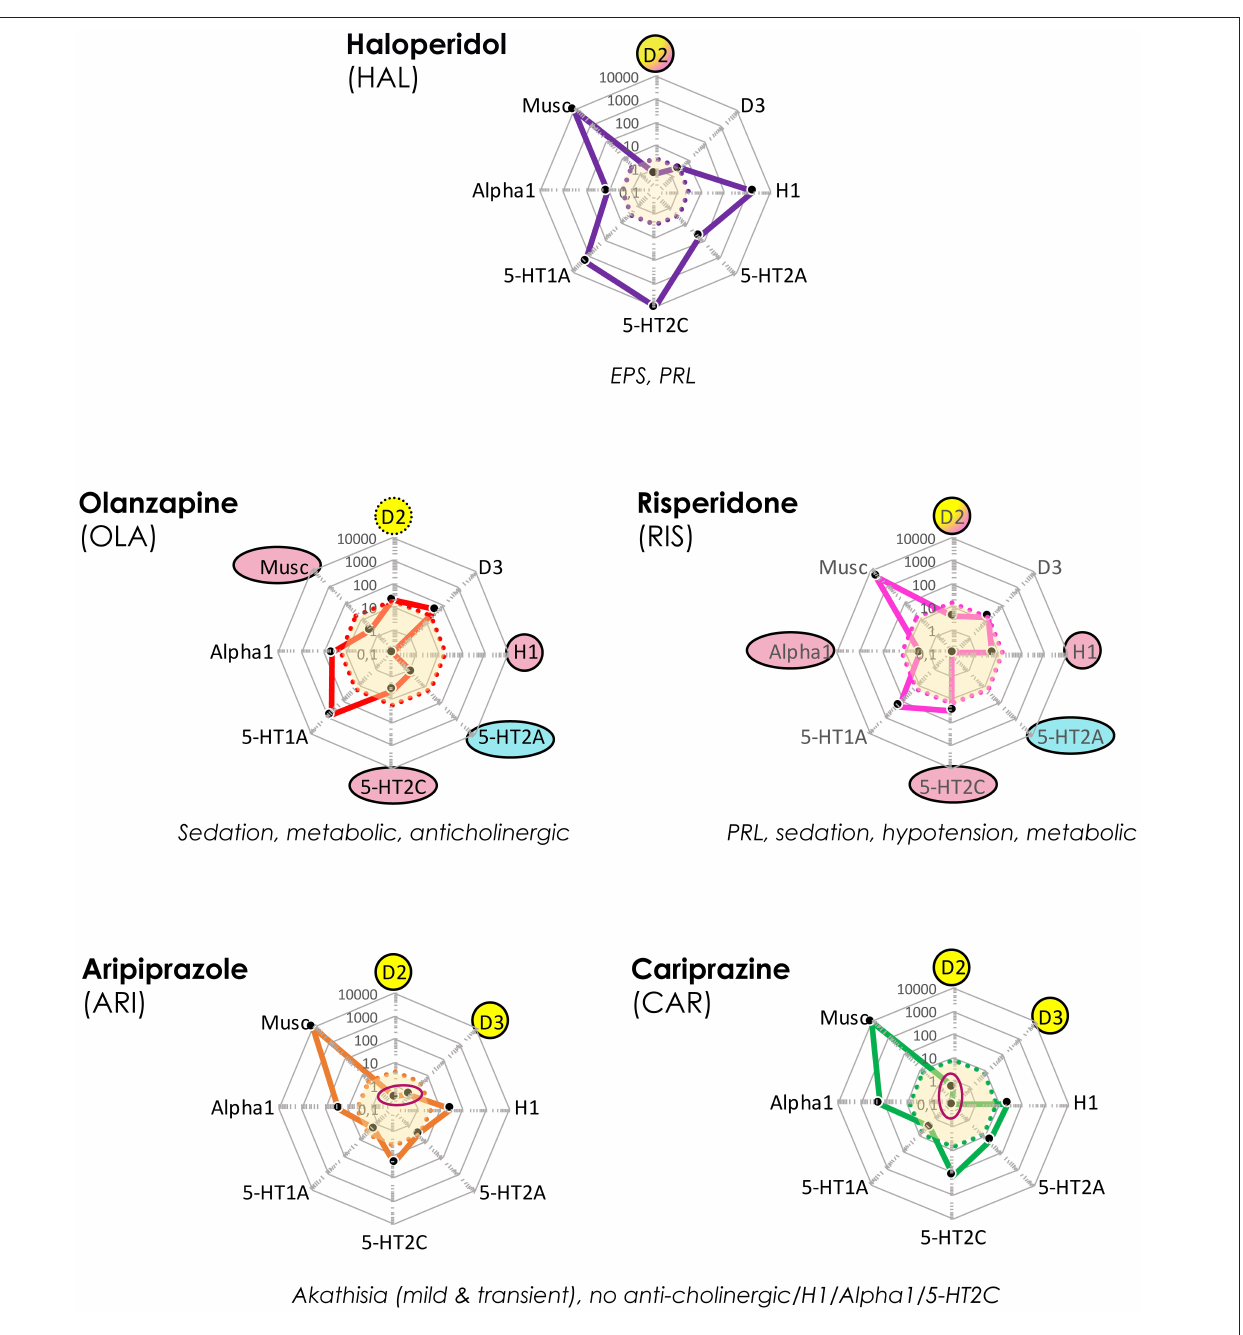
FIGURE 4 | Target and associated AE profiles of HAL, OLA, RIS, ARI, and CAR. Colored lines and dots represent drug profiles based on the 8 different targets depicted at the edges of the cobweb; affinity is highest at the center, lowest at the edges (0.1–10,000nM log scale). Dot line-enclosed shaded areas in the center represent unbound plasma levels of the compounds at efficacious therapeutic dosing. Circles and ovals depict targets likely to be affected at these levels, with colors indicating desired (yellow), accessory beneficial (light blue), and unwanted effects (red; + text below graphs). Red ovals in ARI and CAR graphs pinpoint D2 and D3 affinities. EPS, Extrapyramidal side effects; PRL, prolactin (rise). The drug cobweb profiles in this figure and Figures 5 , 6 were compiled from data in public web databases and complementary literature, including drug SPC’s; viz . human (cloned or native tissue) receptor affinities (22–24); therapeutic steady-state exposures 1 (25); free fraction of drug plasma concentrations (26). Therapeutic steady-state exposure areas shown were obtained by converting ng/mL (25) to nM, and multiplying by the free fraction in plasma (26) for the corresponding drug.